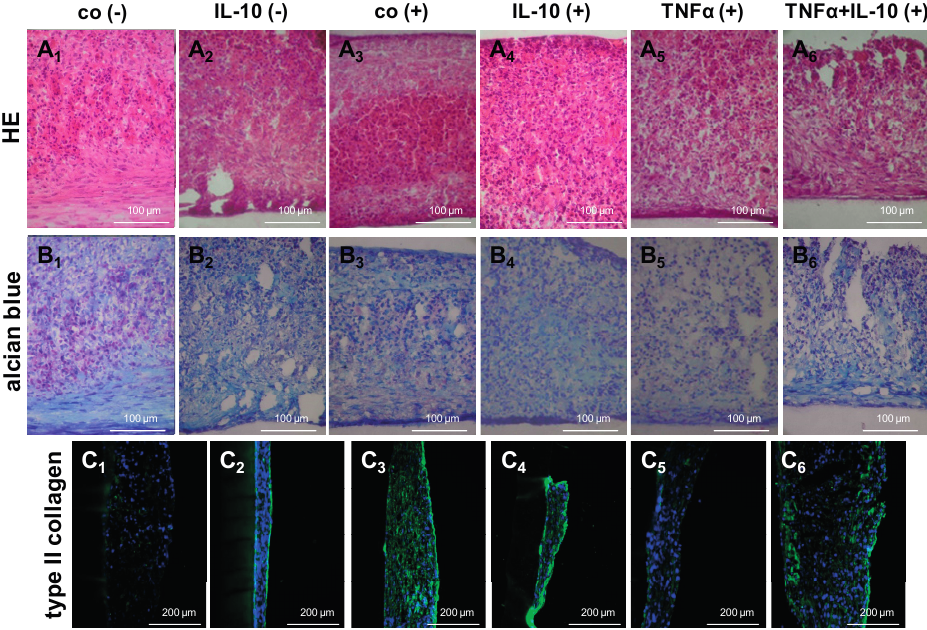
– A ) and alcian blue ( B – B ) stainings were 1 6 1 6 – C ). Cell nuclei 1 6 – A and B – B ), 200 µm ( C – C 1 6 1 6 1 6